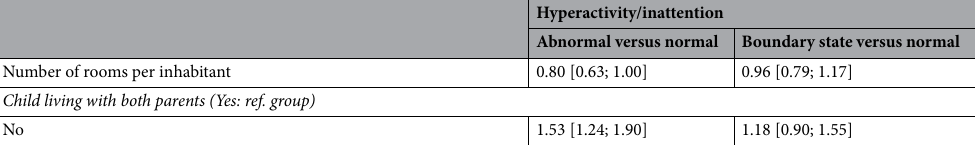
Table 3. Factors associated with hyperactivity/inattention: multinomial logistic regressions adjusted on prematurity (n = 5097). a Region classified according to prevalence of COVID-19 at beginning of epidemic (High: Ile de France and Grand Est vs Medium: Bourgogne-Franche-Comté, Auvergne-Rhône-Alpes and Hauts-de-France vs Low: other